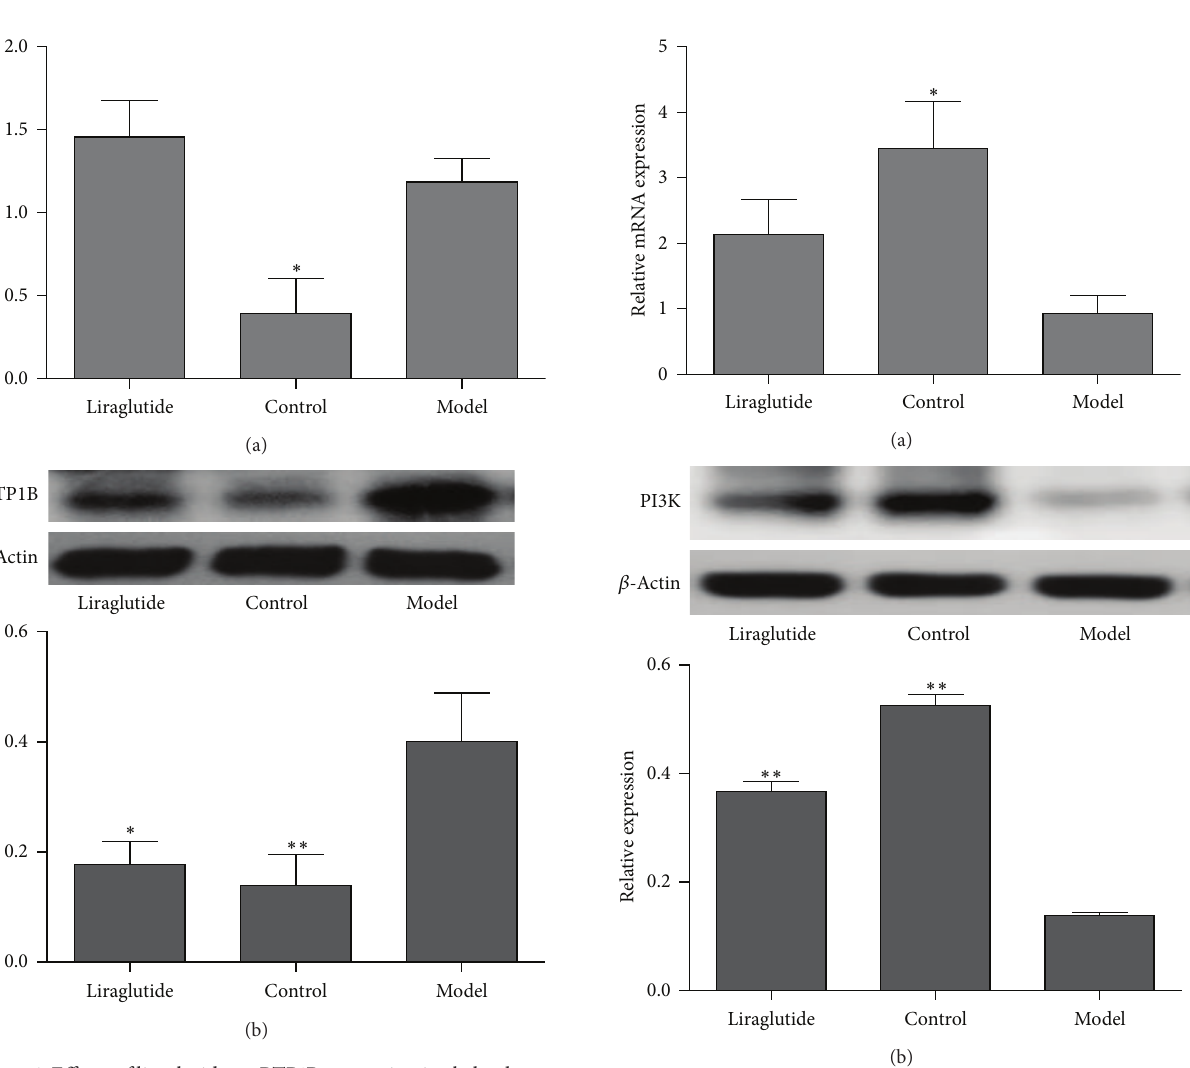
Figure 4: Effects of liraglutide on PTP1B expression in skeletal mus- cle. (a) Expression in skeletal muscle of PTP1B mRNA in normal, model, or liraglutide group. Gene expression was measured by real- time PCR. Relative PTP1B mRNA abundance was normalized by 𝛽 - actin. Data were shown as mean ± SEM, ∗ 𝑃 < 0.05 , ∗∗ 𝑃 < 0.01 versus model group, 𝑛 = 5 . (b) Expression of PTP1B protein in skeletal muscle from normal, model, or liraglutide group. Lysates from freshly isolated skeletal muscle tissues were measured for PTP1B expression by Western blot analysis. Results were shown as mean ± SEM, ∗ 𝑃 < 0.05 , ∗∗ 𝑃 < 0.01 versus model group, 𝑛 = 5 .